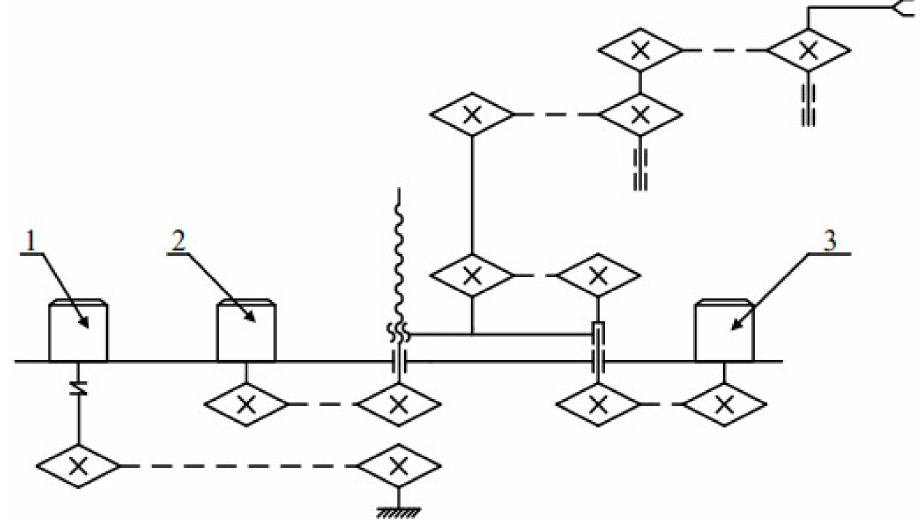
Figure 6. Design of a theoretical drawing for the proposed mechanics. 1: Driving motor for θ -rotation; 2: Driving motor along the Z-axis; 3-Driving motor along the